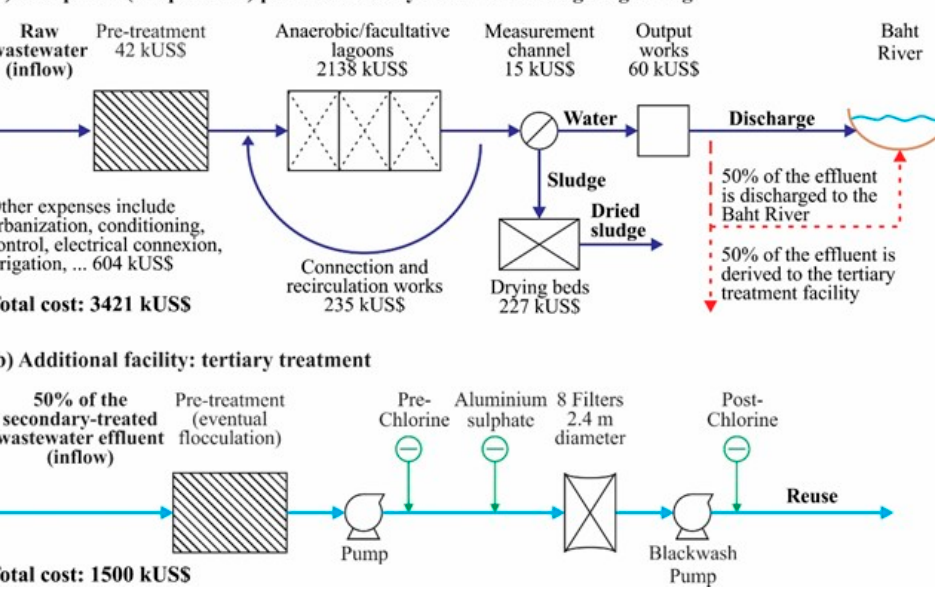
Figure 4. Basic operational scheme of the Sidi Slimane city wastewater treatment plant, showing ( a ) the completed (in operation) unit for secondary treatment through lagooning to meet standards of the Moroccan regulation and ( b ) an additional unit for tertiary treatment to meet the most restrictive standards of the international destination markets. Expenses are expressed in USD.